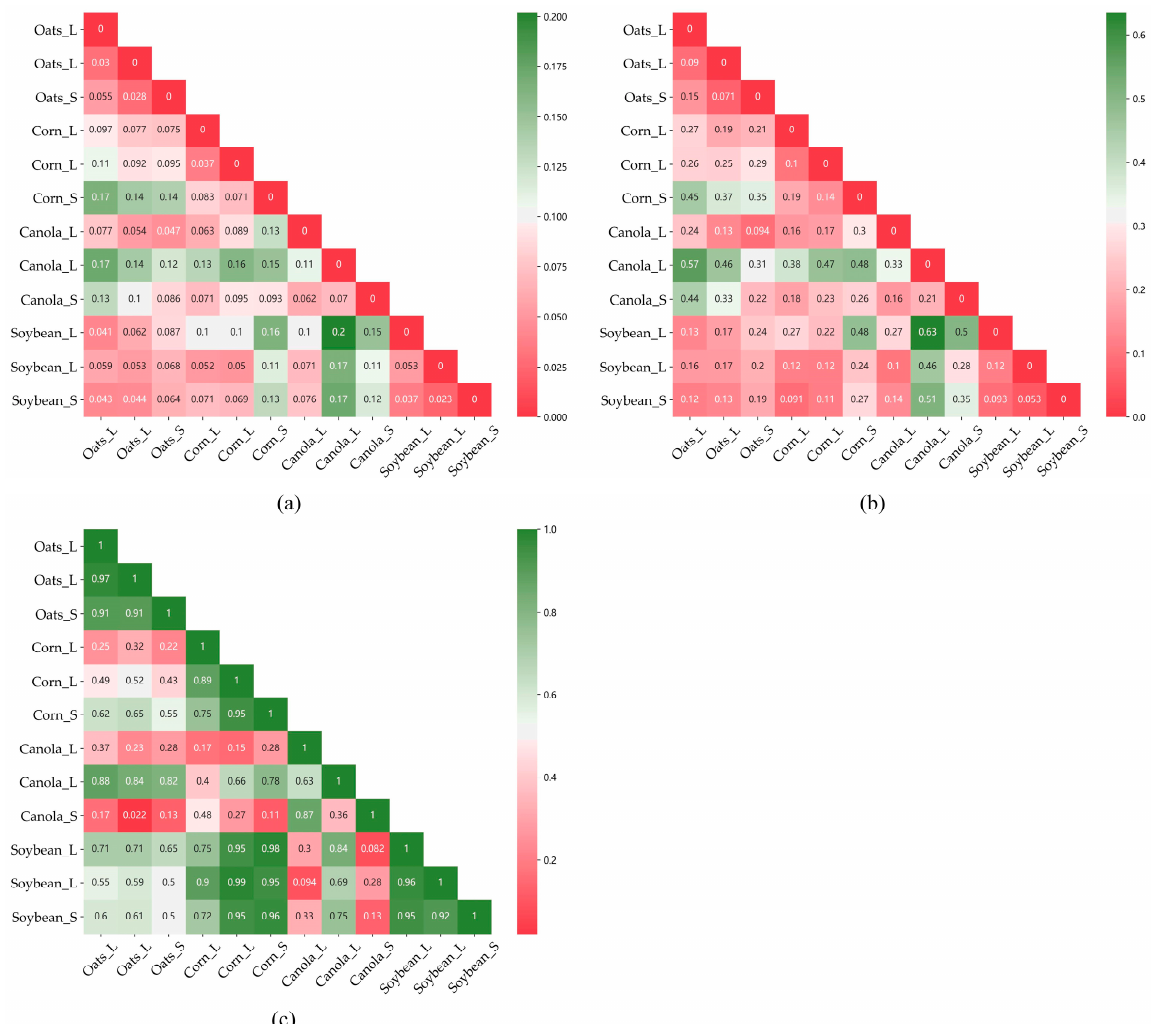
Figure 8. Similarity matrices for the crop time-series curves: ( a ) similarity matrix based on the ED, where 0 denotes the highest similarity; ( b ) similarity matrix based on the DTW, where 0 denotes the highest similarity; ( c ) similarity matrix based on the Pearson correlation coefficient, where 1 denotes the highest similarity.